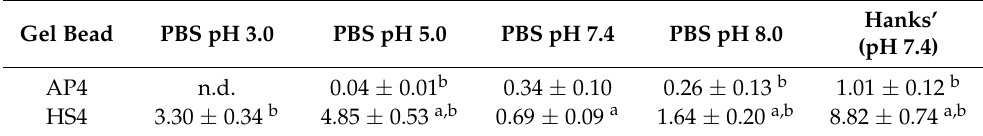
Table 2. The hardness (N) of pectin gel beads after 24 h incubation in PBS and Hanks’ solution. Gel Bead PBS pH